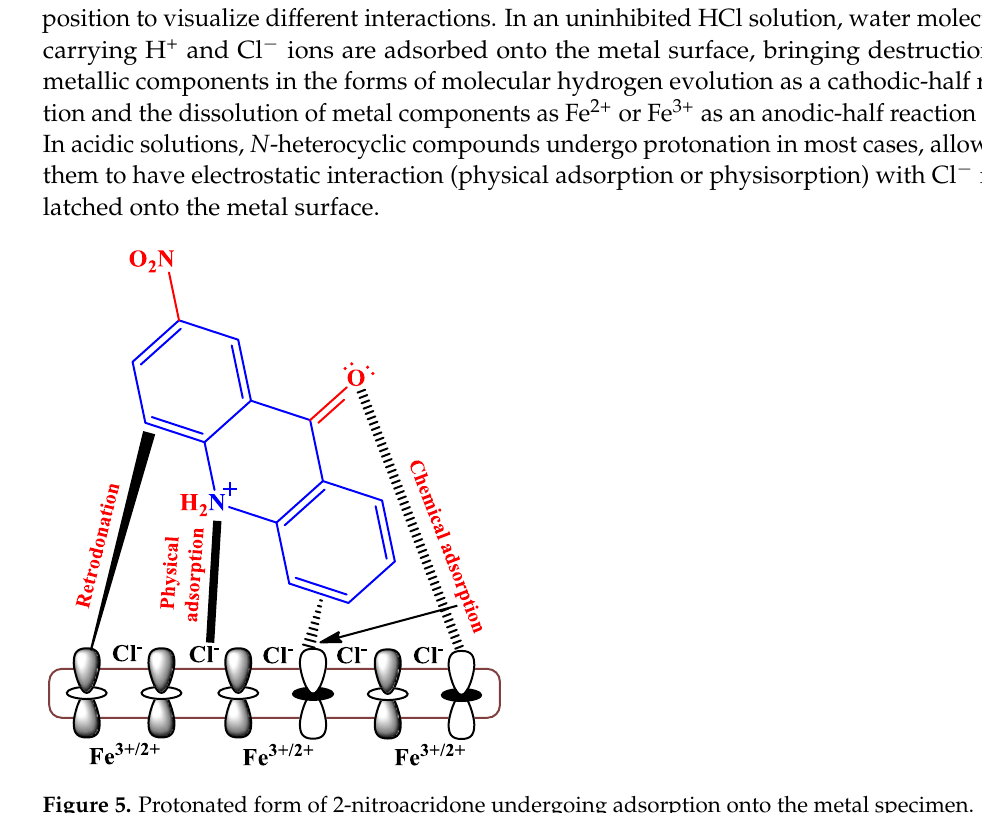
Figure 5. Protonated form of 2-nitroacridone undergoing adsorption onto the metal specimen.